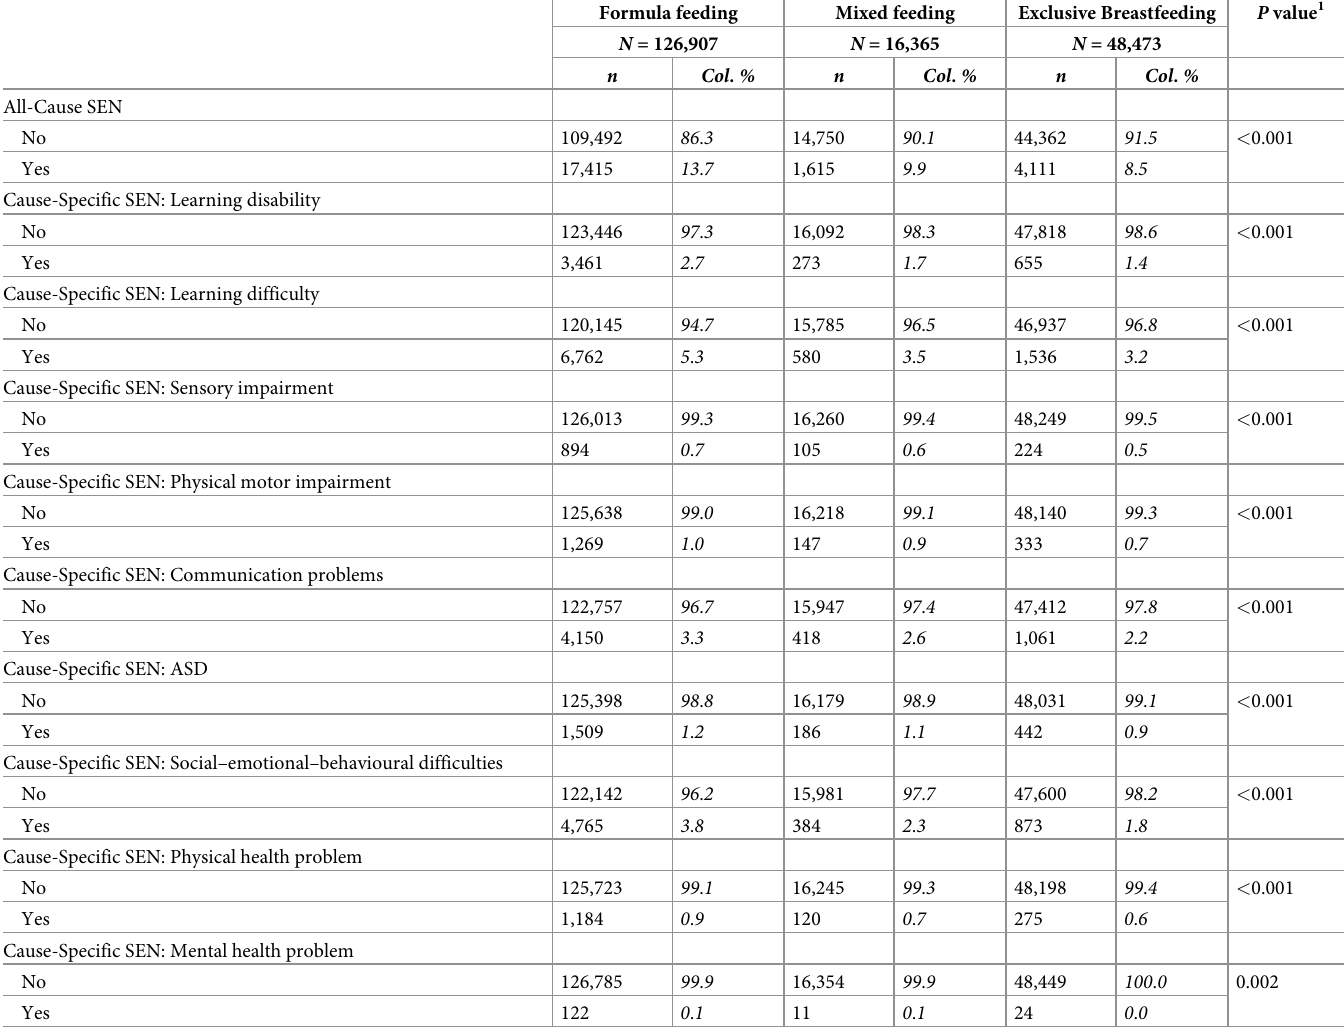
Table 2. Proportion of children with all-cause SEN and cause-specific SEN by feeding method at 6–8 weeks of age. Formula feeding Mixed feeding Exclusive